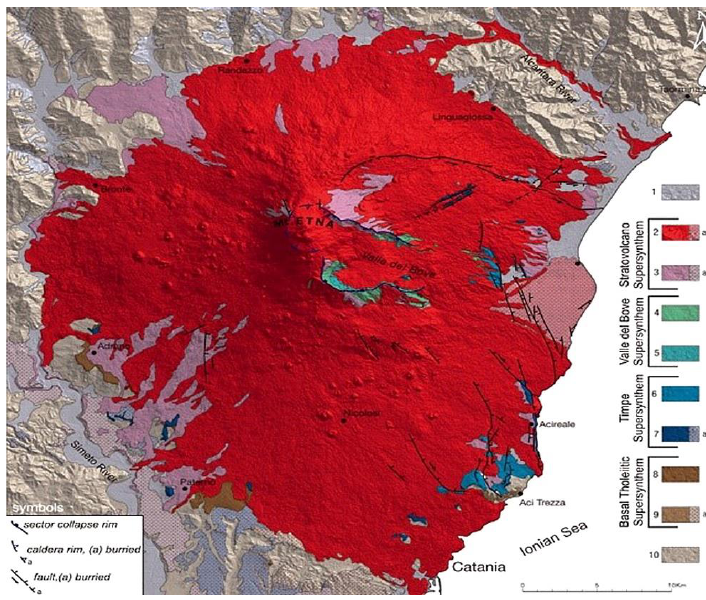
Figure 2. Geological map of Mt. Etna.